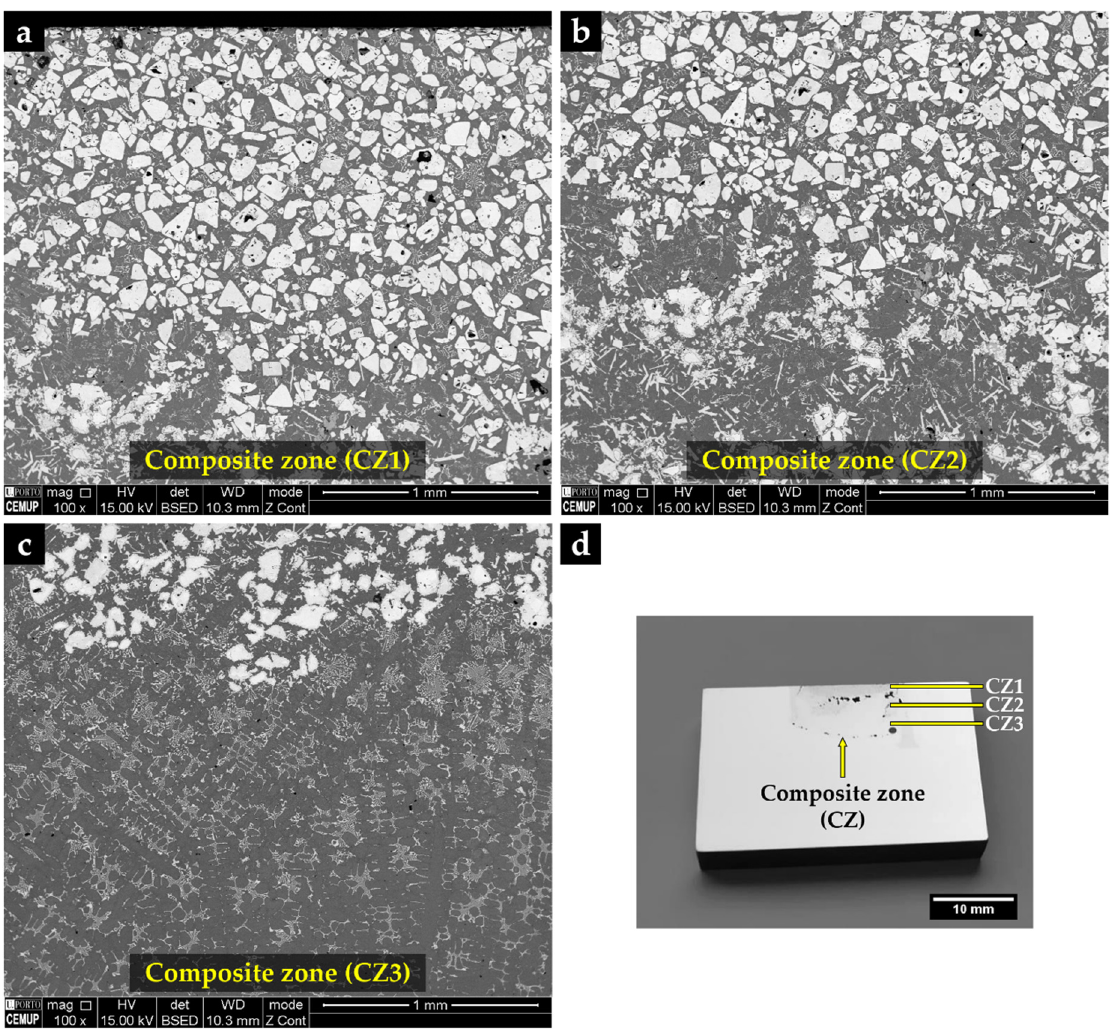
Figure 13. SEM-BSE images of the microstructure of the reinforced specimen showing three zones: composite zone nearest to the surface—CZ1 ( a ), intermediate composite zone—CZ2 ( b ), composite zone next to the base metal—CZ3 ( c ), and a cross-section of the specimen with the identified zones ( d ).